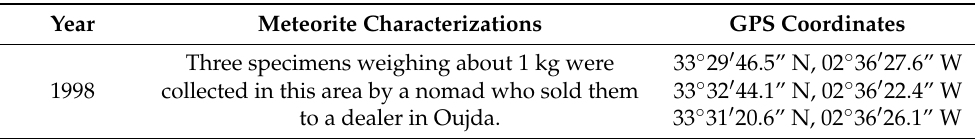
Year Meteorite Characterizations GPS Coordinates Three specimens weighing about 1 kg 1998 were collected in this area by a nomad